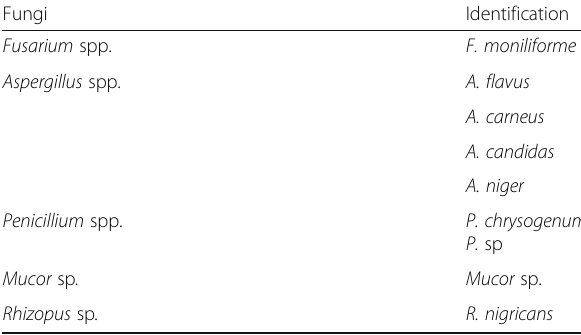
ration samples collected from four